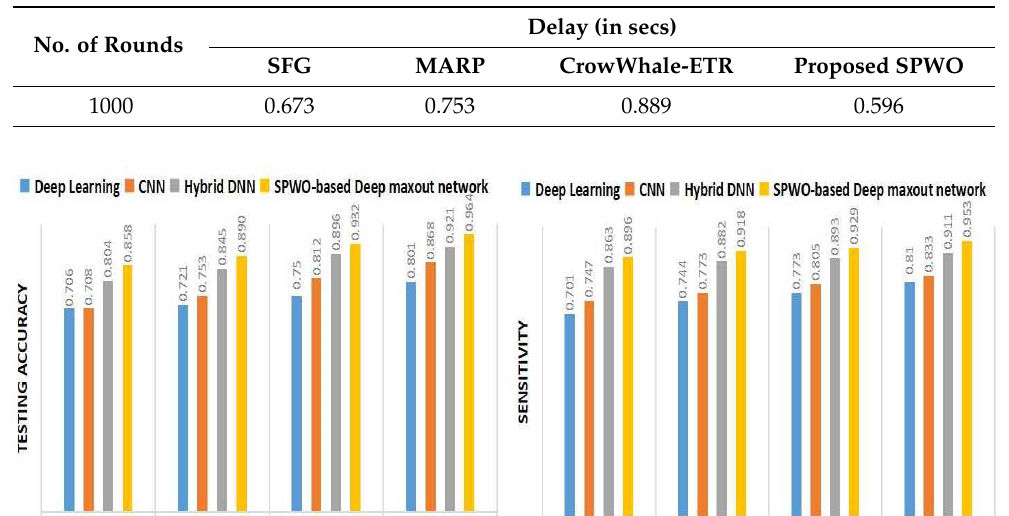
Table 7. Delay Analysis.